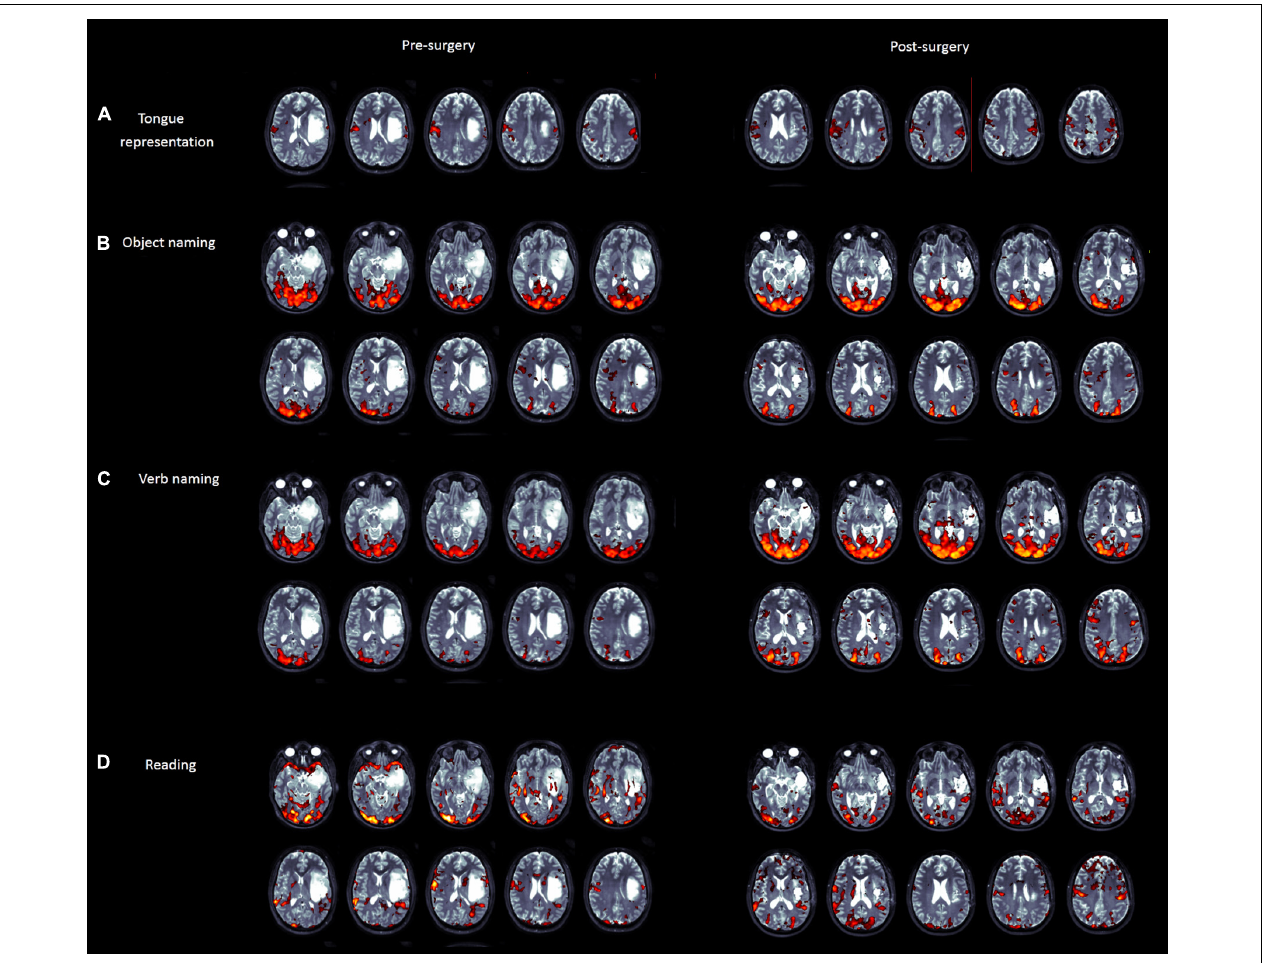
FIGURE 4 | Pre- (left panel) and post (right panel)-surgery DTI reconstructions of the inferior fronto-occipital fasciculus (A) , superior longitudinal fasciculus (B) , and corticospinal tract (C) . Plots (D) represent mean fractional anisotropy (FA) and the number of streamlines for the patient and healthy controls. TABLE 3 | Comparisons of the fractional anisotropy of the patient and number of streamlines vs. healthy controls ( N = 25). LH RH CST